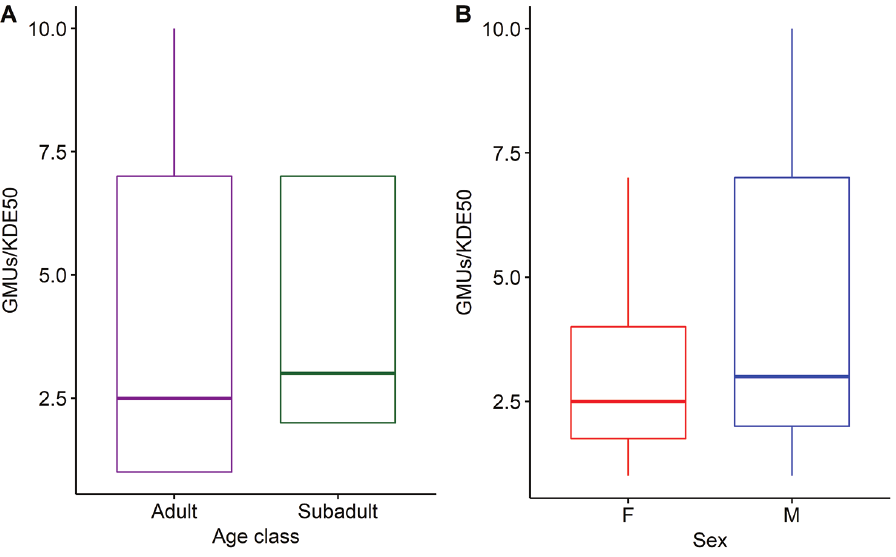
Figure 5. Number of Game Management Units (GMUs) overlaping subadult/adult brown bears ( A ) and females/males ( B ) core areas (KDE50) in Eastern Romanian Carpathians and Subcarpathians (box = interquartile range, horizontal line = median, whiskers = 1.5 × interquartile